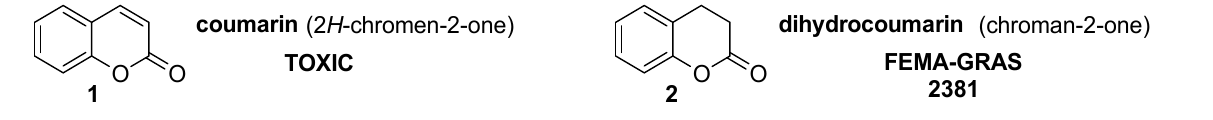
Figure 1. The coumarin ( 1 ) and dihydrocoumarin ( 2 ) structures.